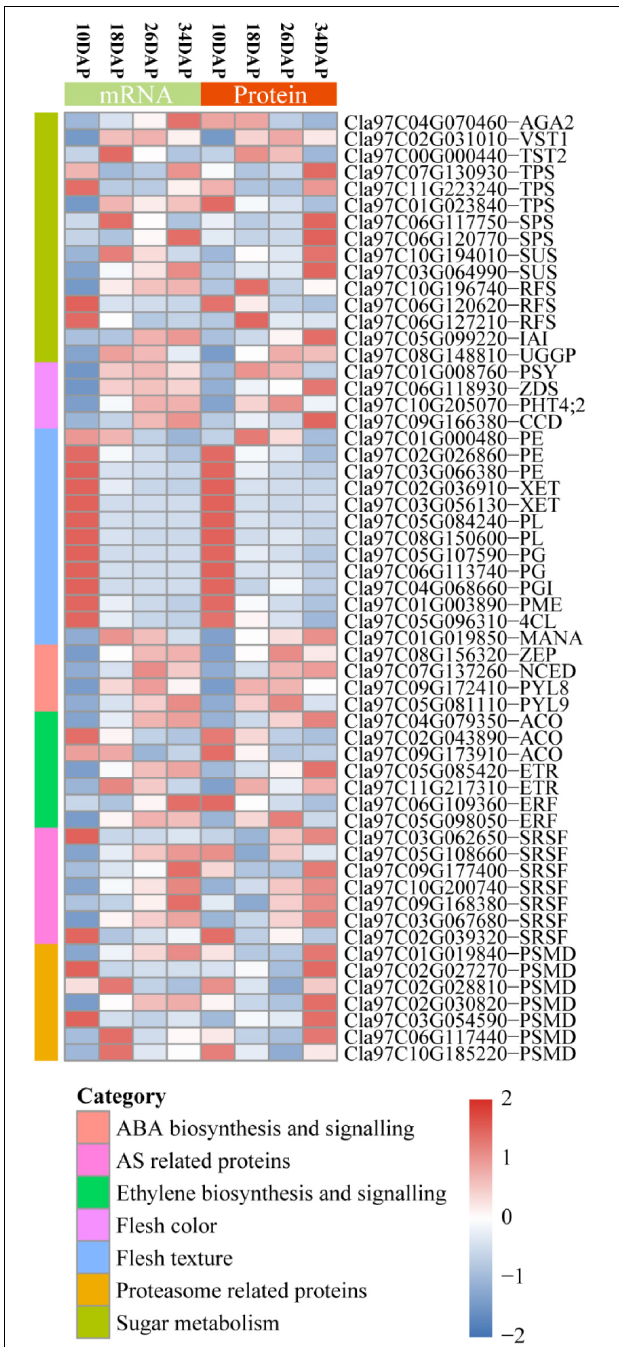
FIGURE 6 | Heatmap for protein and mRNA expression of a subset of fruit ripening-associated genes. The Stat.mean values represent the averaged magnitude, and direction of fold changes at the gene set level corresponds to the color-coded up-regulated (red) and down-regulated (blue) changes. AGA2, α -galactosidase 2; VST1, vacuolar sugar transporter 1; TST2, tonoplast sugar transporter 2; TPS, trehalose-phosphate synthase; SPS, sucrose phosphate synthase; SUS, sucrose synthase; IAI, insoluble acid invertase; RFS, raffinose synthase; UGGP, UDP-Gal/Glc PPase; PSY, phytoene synthase; ZDS, zeta-carotene desaturase; PHT4;2, phosphate